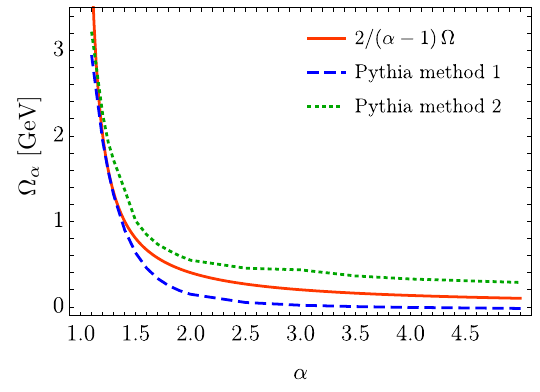
Pythia (cid:11) extracted from